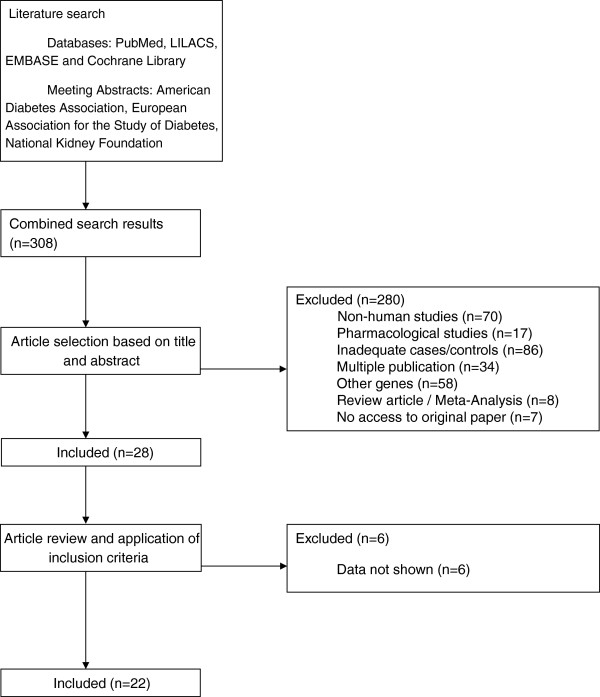
Search strategy.